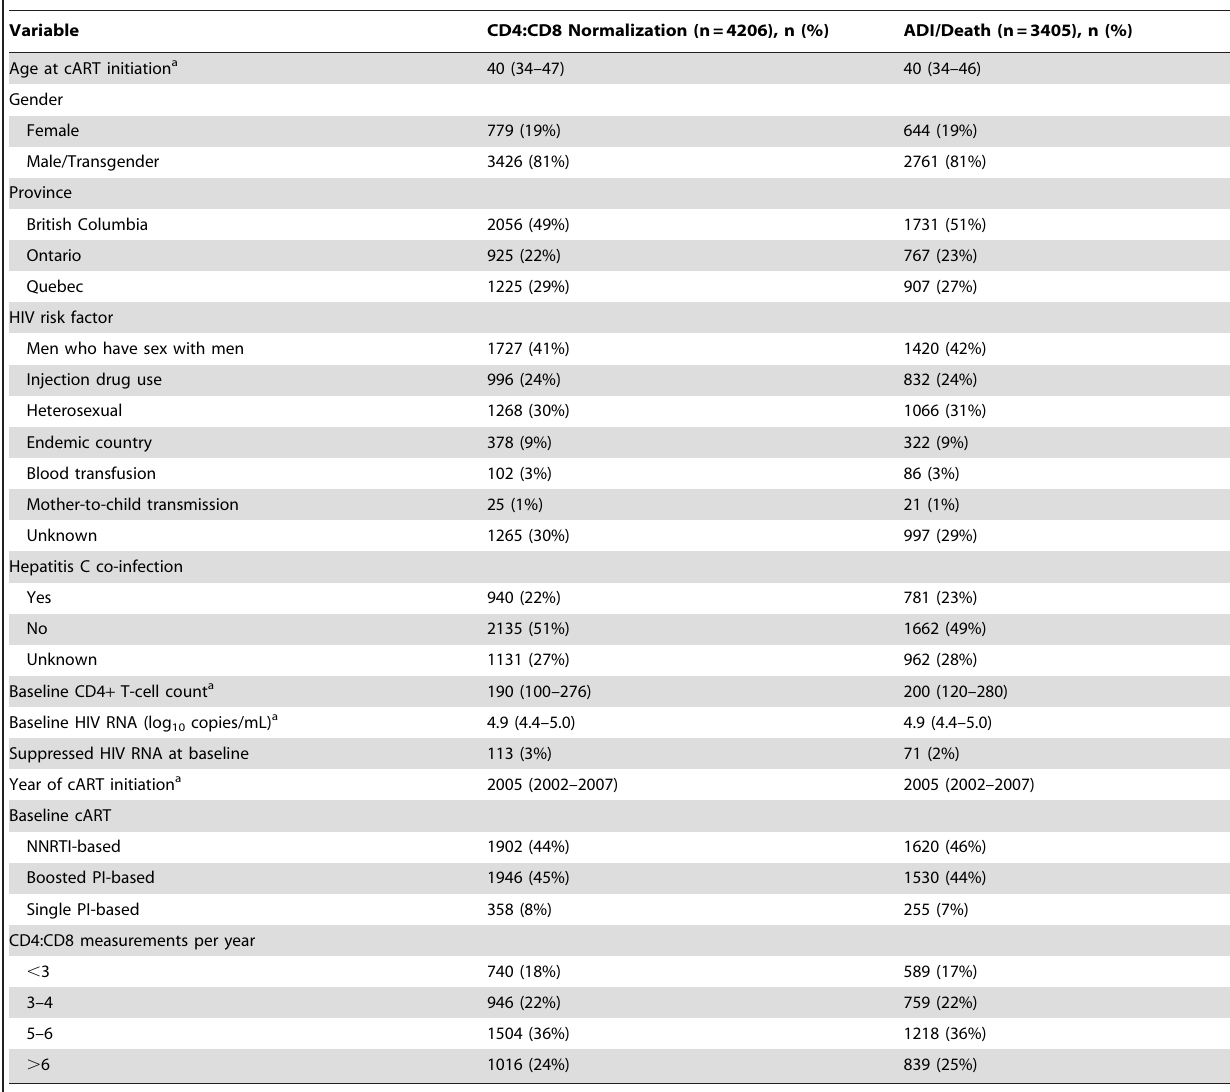
Table 1. Baseline characteristics of participants in the time to CD4:CD8 normalization and time to ADI/death analyses.